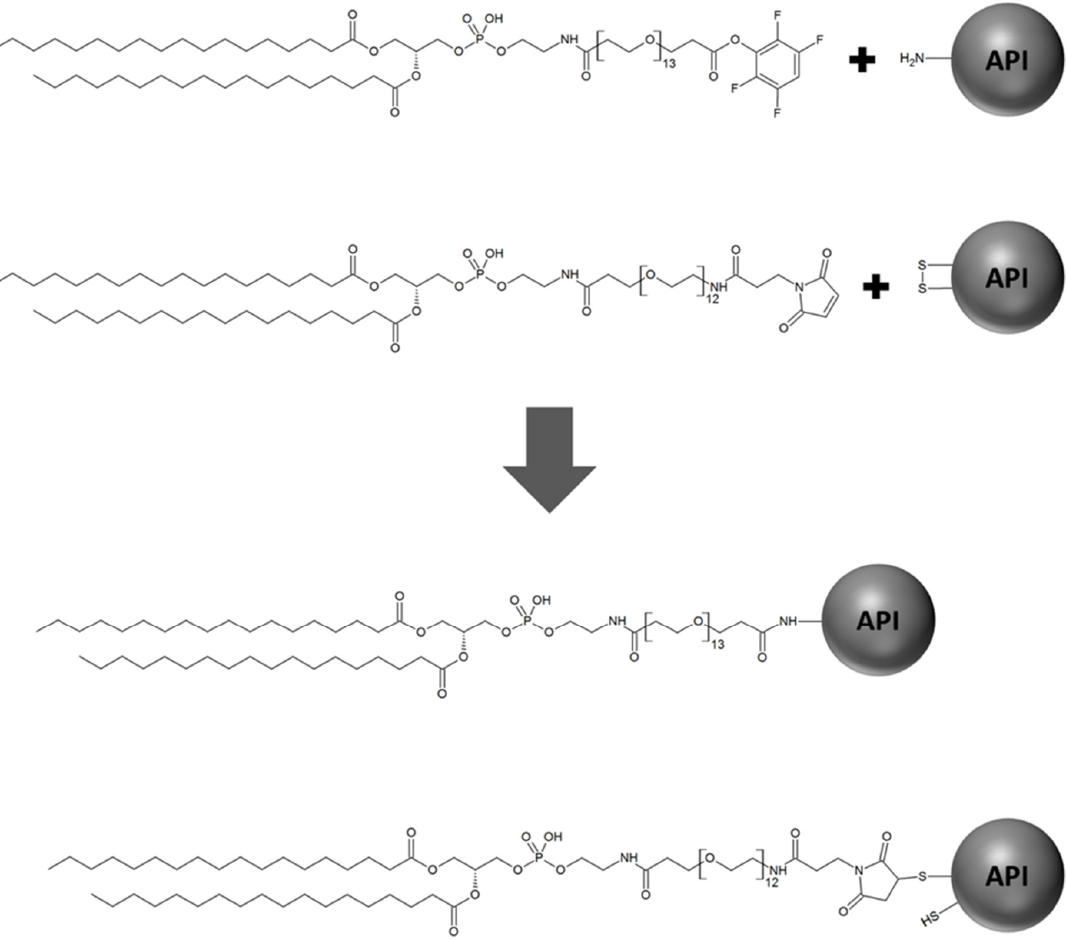
Figure 1. Scheme of the possible cross-reaction of activated ester and maleimide groups of phospholipids with amino and disulfide groups of active pharmaceutical ingredients (APIs).